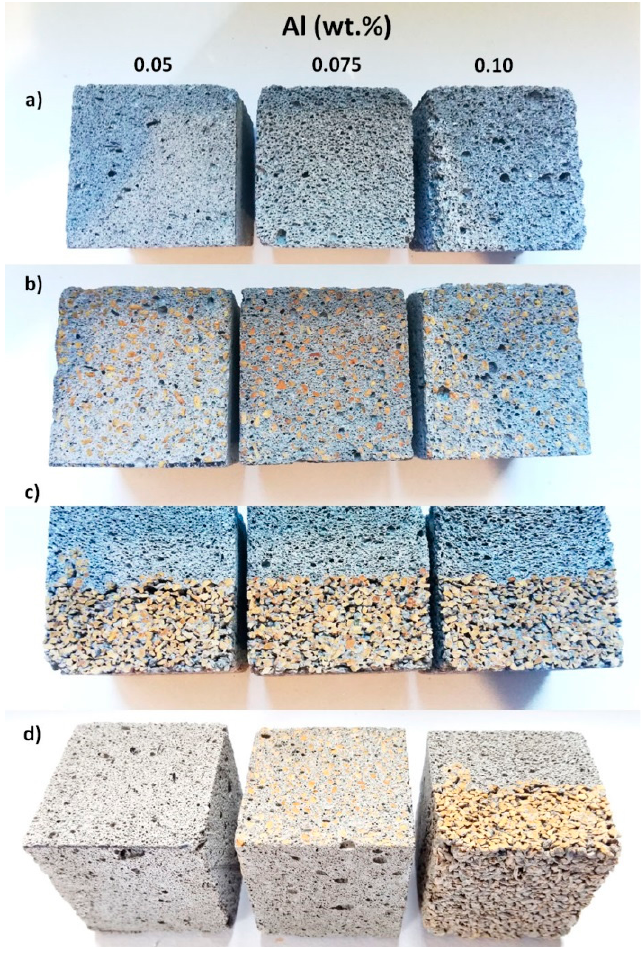
Figure 3. Digital photographs of the ( a ) inorganic polymer foams, ( b ) cork-containing foams, and ( c ) bi-layered composites containing varying amounts of Al. ( d ) shows a comparison between the three set of samples prepared using the same amount of Al (0.05 wt.%).